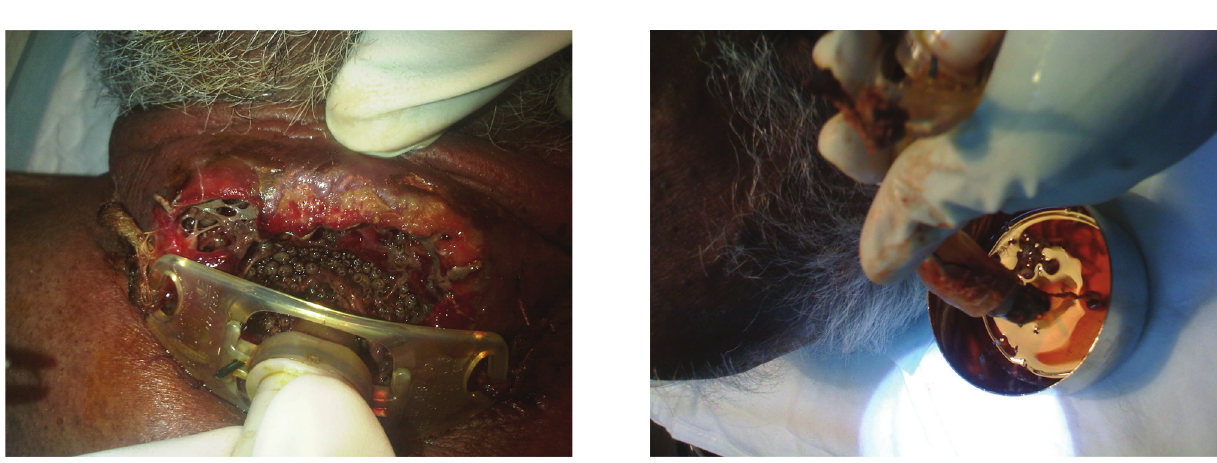
Figure 1: Maggots seen around the tracheostoma.